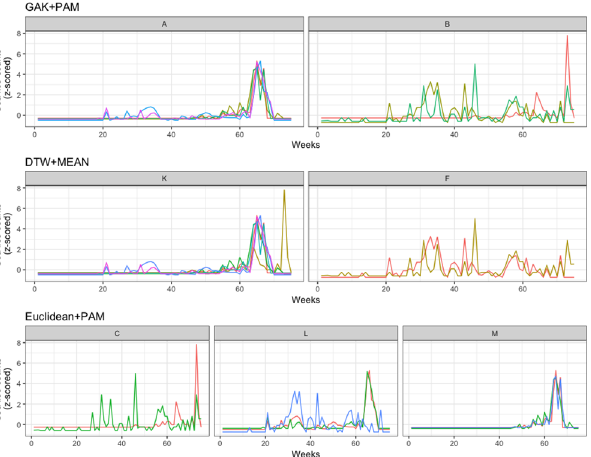
Fig 3. Farm I clustering for 2014-2015. Time-series plots for the most stable clustering algorithms for Farm I, production cycle of 2014-2015.